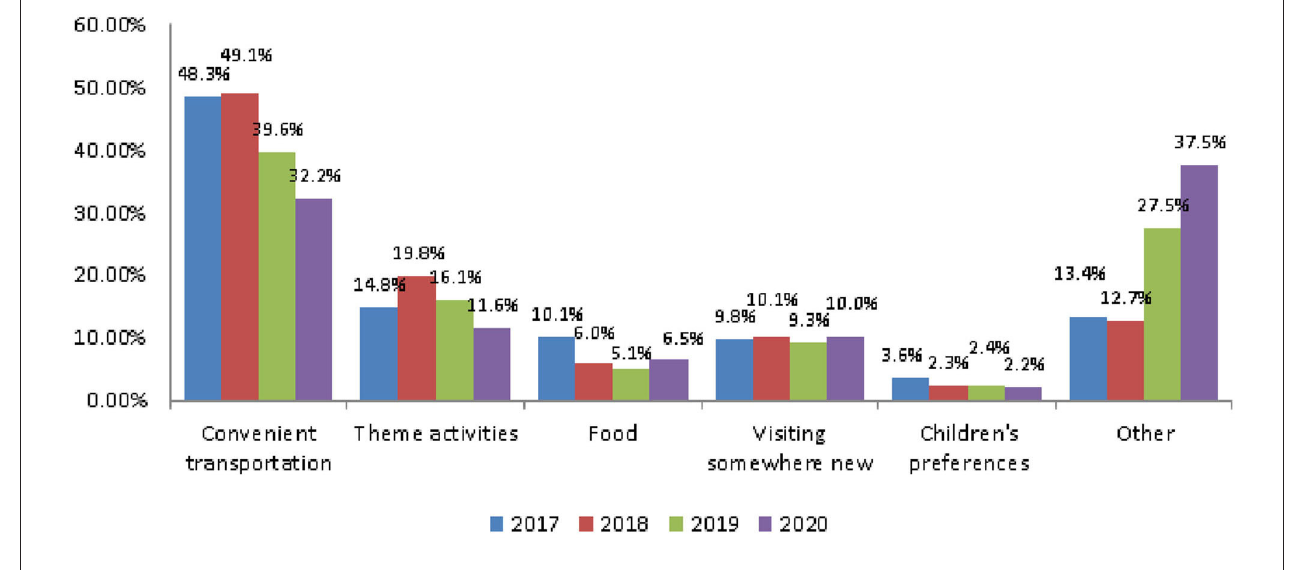
FIGURE 4 | The trend of reasons for choosing a tourist attraction. TABLE 5 | The reasons for choosing a tourist